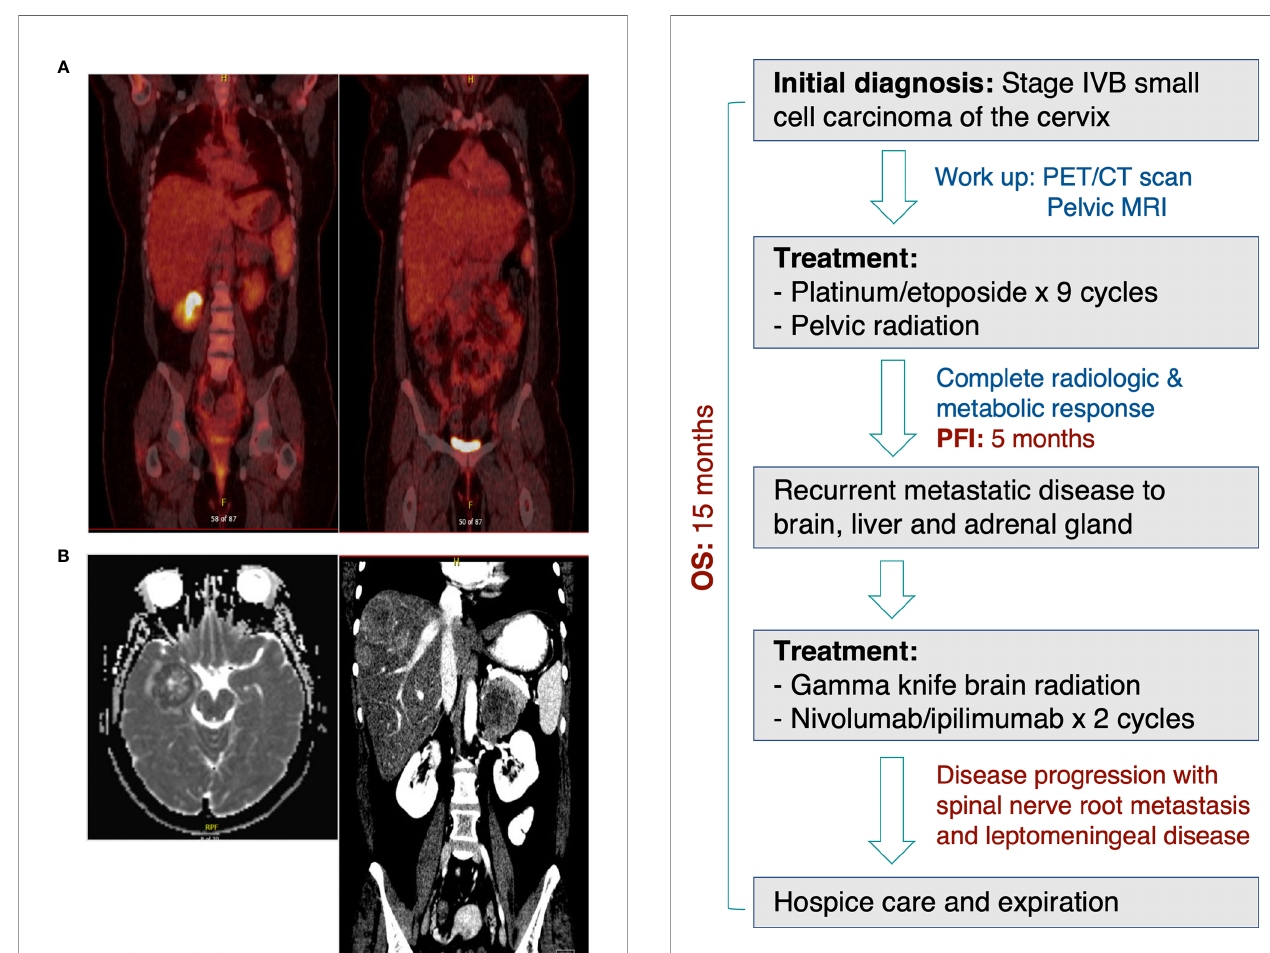
FIGURE 3 | A schematic representation showing treatment course and timeline.